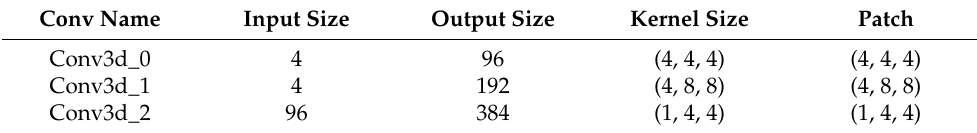
Table 2. The parameters of 3D Conv.